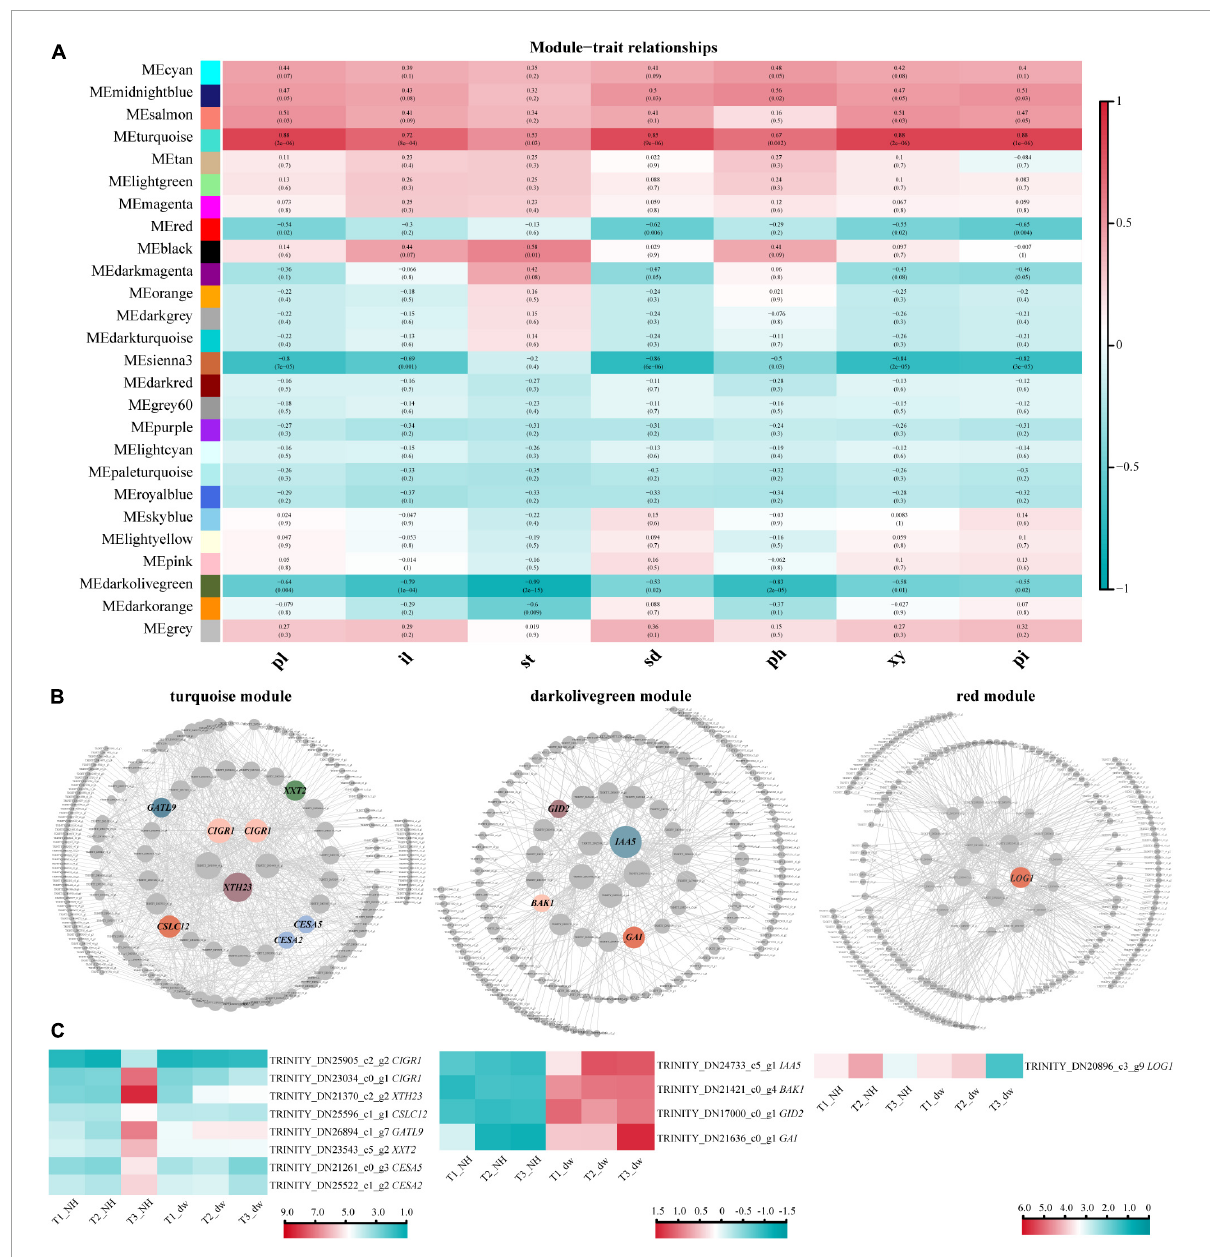
FIGURE5 WGCNA and HUB genes of three key modules. (A) Association between modules and phenotypic traits. pl, plant height; il, internode length; st, length of stem tip; sd, stem diameter; ph, phloem thickness; xy, xylem thickness; pi, pith diameter. (B) HUB gene interaction network. CIGR1, chitin-inducible gibberellin-responsive protein 1; XTH23, probable xyloglucan endotransglucosylase/hydrolase protein 23; CSLC12, probable xyloglucan glycosyltransferase; GATL9, probable galacturonosyltransferase-like 9; XXT2, xyloglucan 6-xylosyltransferase 2; CESA2, cellulose synthase A catalytic subunit 2; CESA5, cellulose synthase A catalytic subunit 5; IAA5, auxin-responsive protein IAA5-like; BAK1, brassinosteroid insensitive 1-associated receptor kinase 1-like; LOG1, cytokinin riboside 5 (cid:48) -monophosphate phosphoribohydrolase LOG1. (C) Heat map of HUB gene